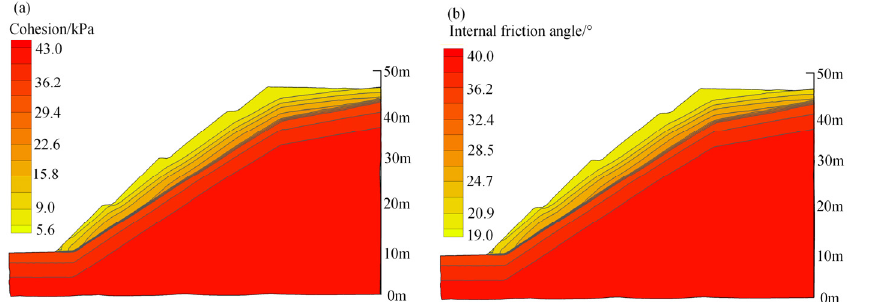
Figure 12. Contour maps of shear strength parameters that consider weathering and water-softening effects: ( a ) cohesion; ( b ) angle of internal friction.